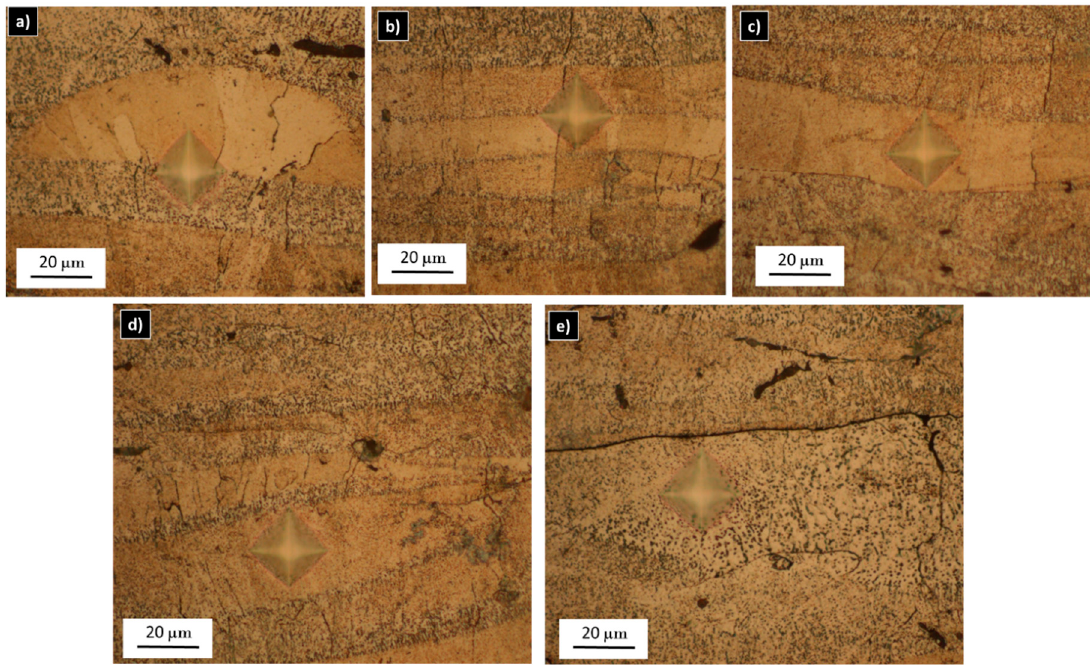
Figure 10. Micro-hardness measurement at a layer-layer interface ( a , b ), inside some layers with different microstructure ( c – e ).